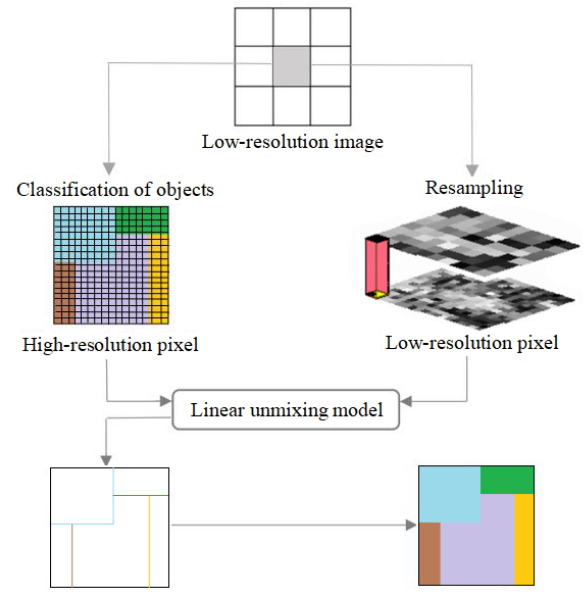
Figure 3. Mechanism of the linear spectral mixture model.